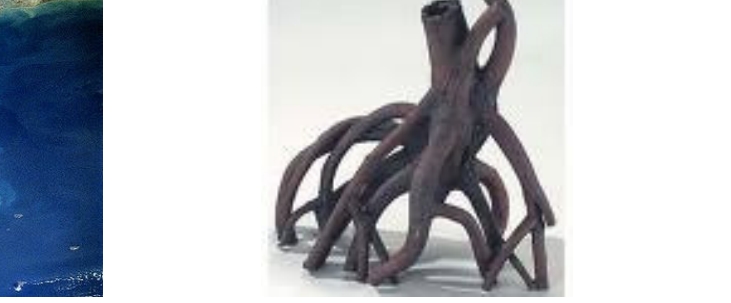
Figure 4: Satellite image of Persian Gulf. Figure 5: Mangrove root